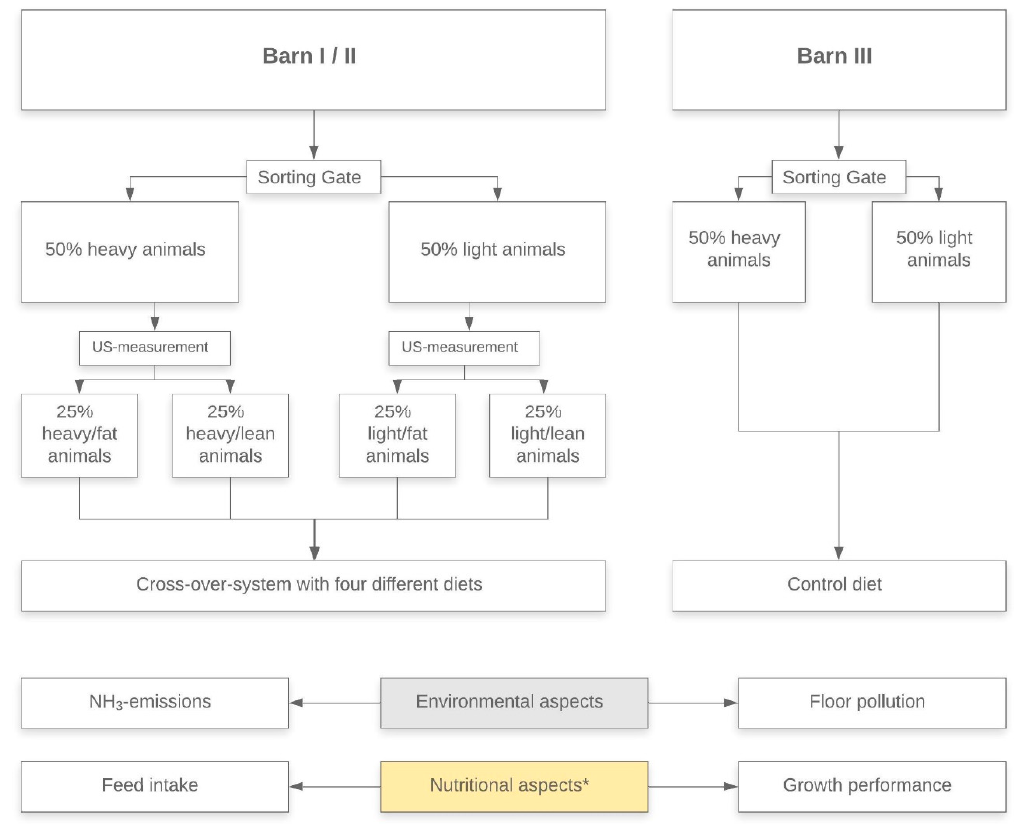
Figure 1. Overview of the measurements done in the different barns. Barn I and II were used for experimental groups with crude fiber supplemented diets. Barn III was used for control group with standard diet (US stands for ultrasound).* Data of nutritional aspects only collected in Barn I.